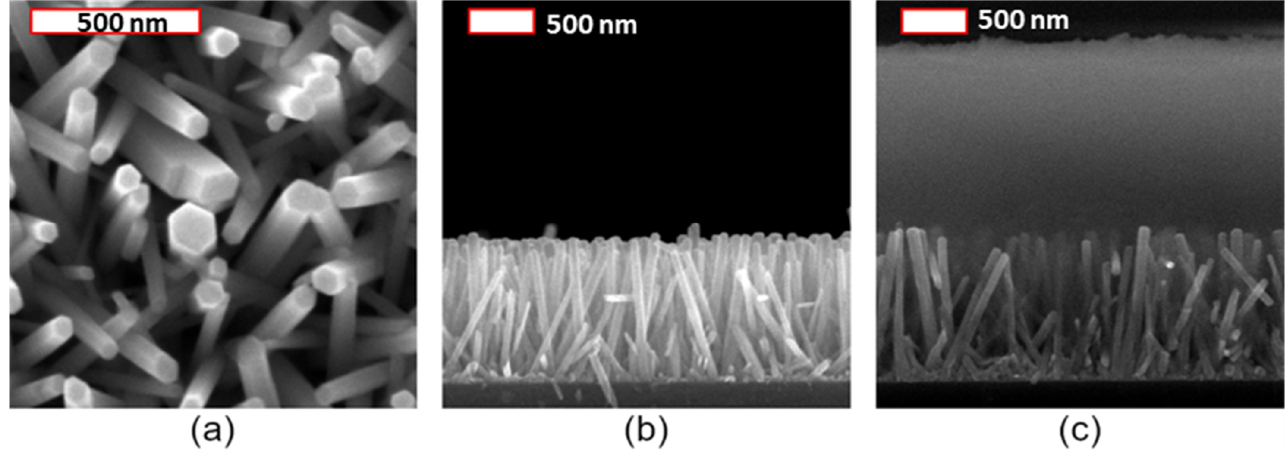
Figure 12. FESEM images of ( a ) top view and ( b ) cross-section view of ZnO NWs grown by CBD. Image ( c ) depicts the ZnO NW arrays, with a PMMA matrix exhibiting a thickness of ~1.5 µm in the top.